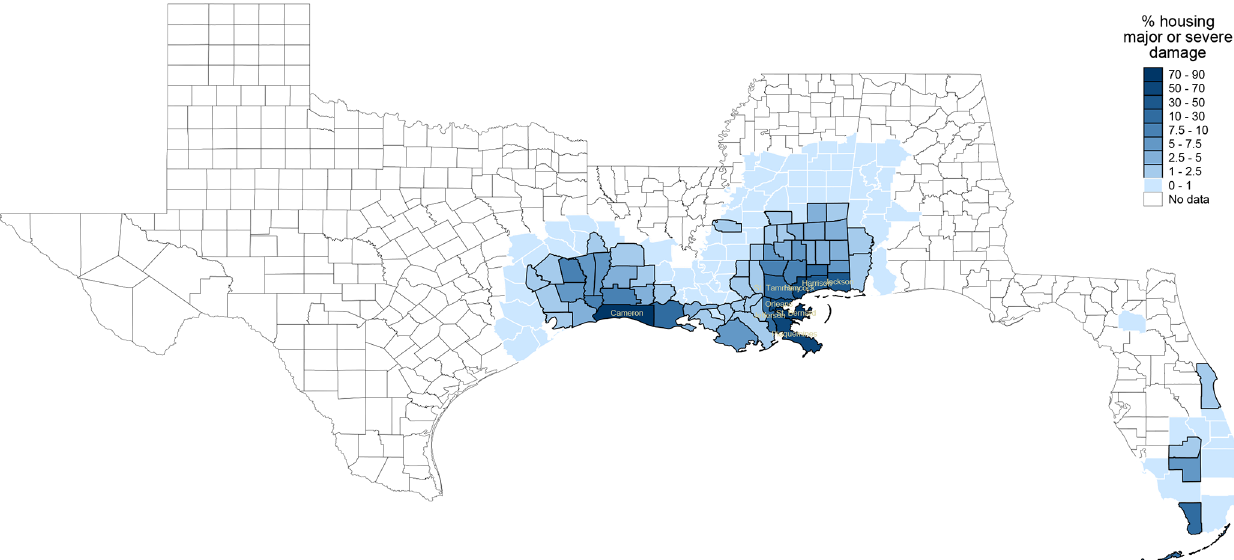
Figure A3. Housing damage due to hurricanes Katrina, Rita, and Wilma. Data for the states of Texas, Louisiana, Mississippi, Alabama, and Florida. Own calculations, based on U.S. Department of Housing and Urban Development (2006) data from FEMA Individual Assistance registrants and Small Business Administration disaster loan applications. Counties with major/severe damage of 15% or more are labeled in the map. Damages for the counties in western Louisiana are related to Hurricane Rita, which made landfall on the coastline of Texas on 24 September 2005. Most notable is Cameron County, with major or severe damage to over 70% of its housing stock. Hurricane Wilma made landfall in the south of Florida on 24 October 2005, causing housing damage to several thousands of homes making up at most 10% of the housing stock in affected counties.